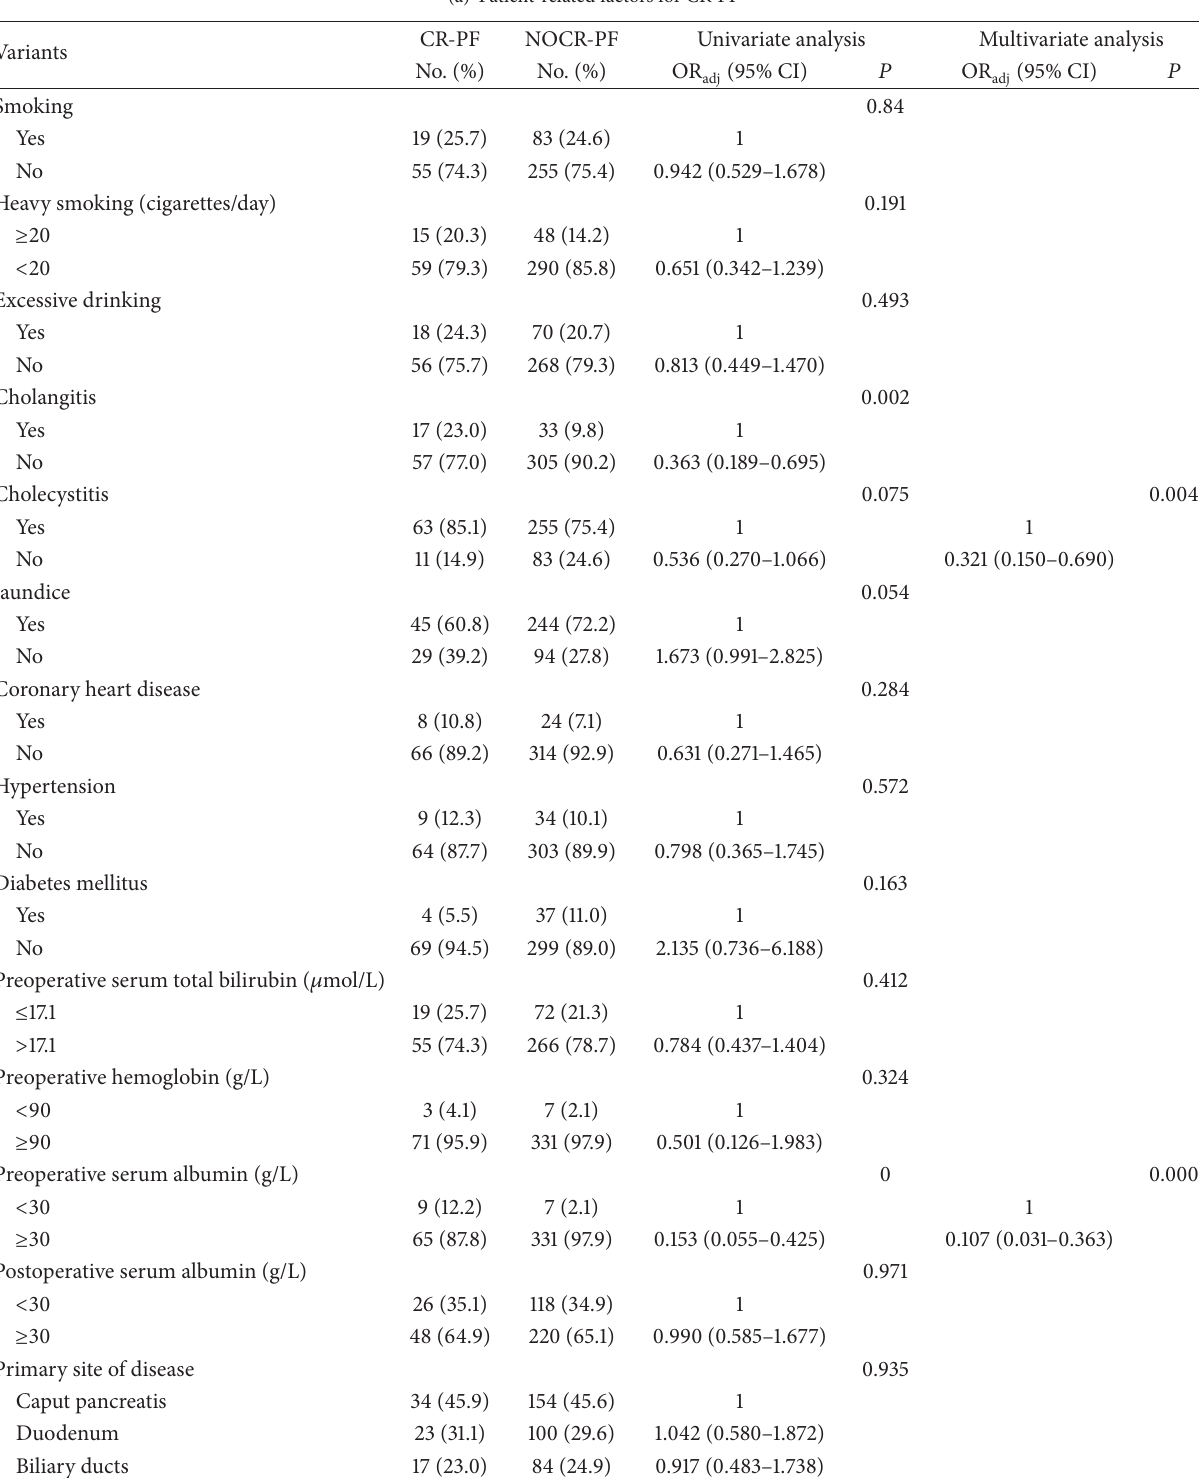
Table 3: Analysis for potential risk factors of pancreaticocutaneous fistula (CR-PF) factors (univariate and multivariate analysis). (a) Patient-related factors for